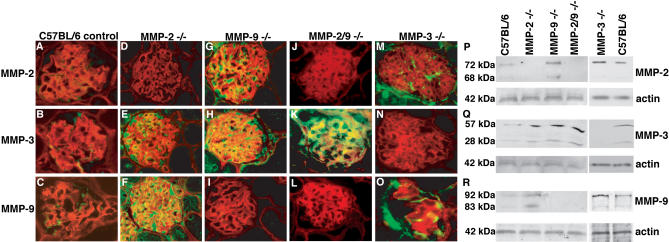
Compensation of BM-Degrading MMPs in
MMP-2
−/
−
, MMP-3
−/
−
, and
MMP-9
−/− Mice, and in
MMP-2
−/− and
MMP-9
−/− Mice
Immunohistochemical staining was performed with MMP-2, MMP-3, or MMP-9–antibodies (green) and with antibodies for entactin (red) on frozen kidney sections from
MMP-2
−/− and
MMP-9
−/− mice, and from
MMP-2
−/− and
MMP-9
−/− mice plus C57Bl/6 age-matched control mice.
(A–C) Wild-type control kidney. Immunohistochemical staining demonstrated basal expression of MMP-2, MMP-3, or MMP-9 in the glomeruli of C57BL/6 mice.(D–F)
MMP-2
−/− kidney. In
MMP-2
−/− mice, the absence of MMP-2 was associated with a compensatory increase of MMP-3 and MMP-9.
(G–I)
MMP-9
−/− kidney. MMP-9–deficiency was associated with increased MMP-2– and MMP-3–staining.
(J–L)
MMP-2
−/− and
MMP-9
−/− kidney. The absence of both MMP-2 and MMP-9 was associated with a substantial increase of MMP-3 in the glomeruli of
MMP-2
−/− or
MMP-9
−/− double-mutant mice.
(M–O)
MMP-3
−/− kidney. In
MMP-3
−/− mice, the absence of MMP-3 was associated with increased glomerular staining for MMP-2 and MMP-9.
(P–R) Immunoblot analysis. Immunoblot analysis of total kidney-cortex protein preparations with antibodies specific for MMP-2 (M), MMP-3 (N), and MMP-9 (O) confirmed compensatory up-regulation of MMPs. The blots were stripped and reprobed with antibodies to actin in order to confirm equal loading (lower panels).